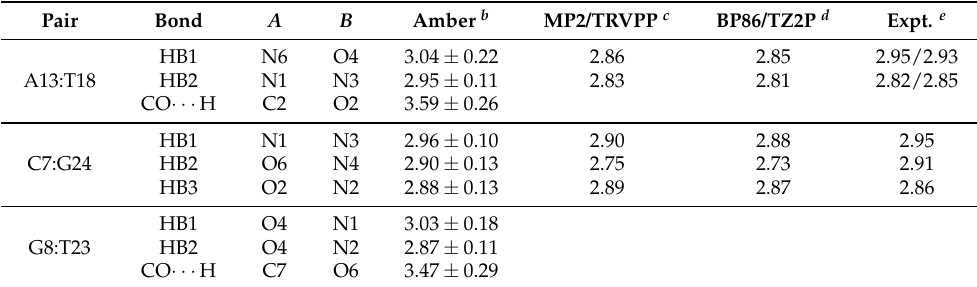
Table 6. Theoretical and experimental bond lengths R AB (Å) in Watson–Crick base pairs a